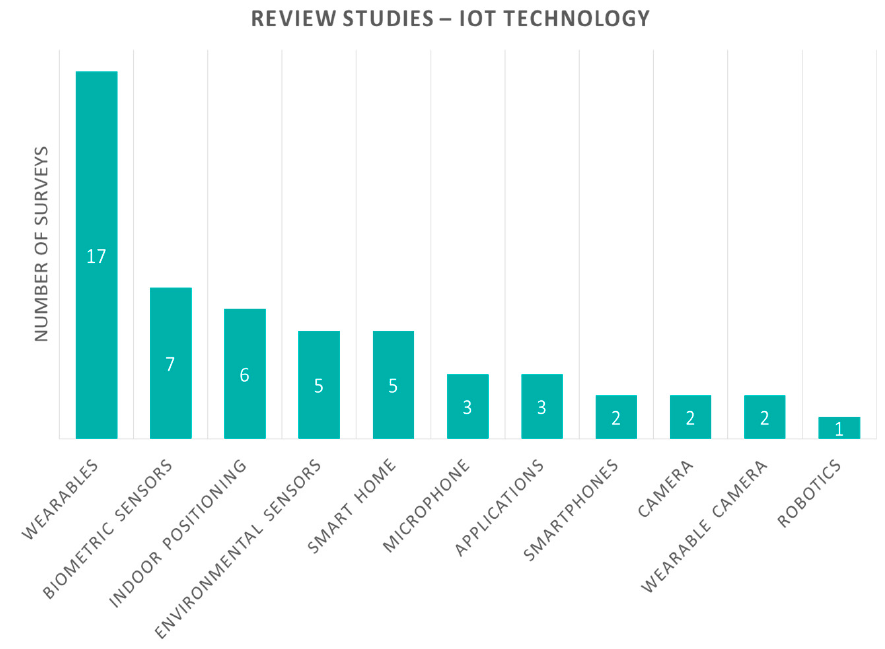
Figure 4. Review studies according to Internet of Things (IoT) technology devices are presented.